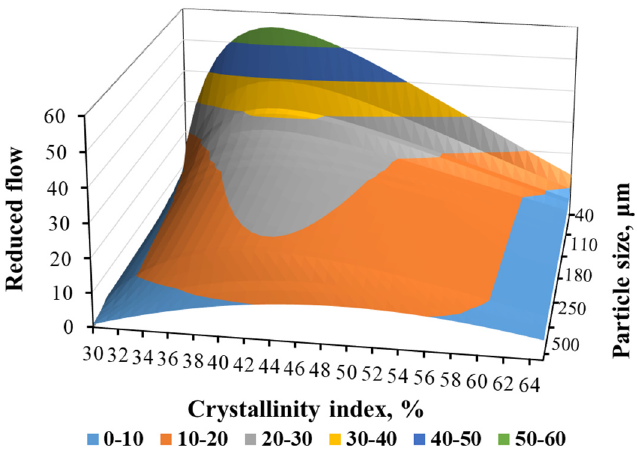
Figure 7. Resveratrol flow during the extraction process, depending on the crystallinity index and particle size.